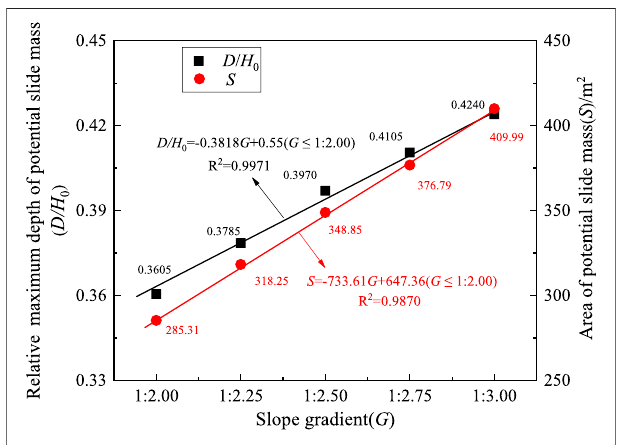
FIGURE 6 | Variations of relative maximum depth and area of potential slide mass with slope gradient at H = 20 m.